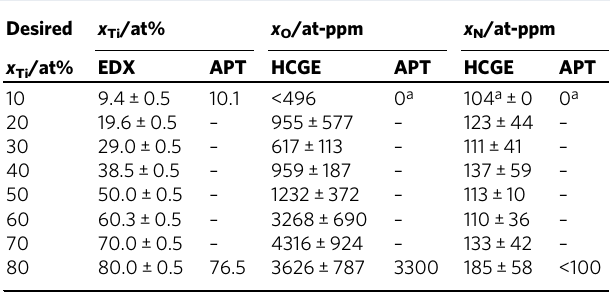
Table 2 Chemical composition of the Mo-Ti alloys using EDX, APT and HCGE.